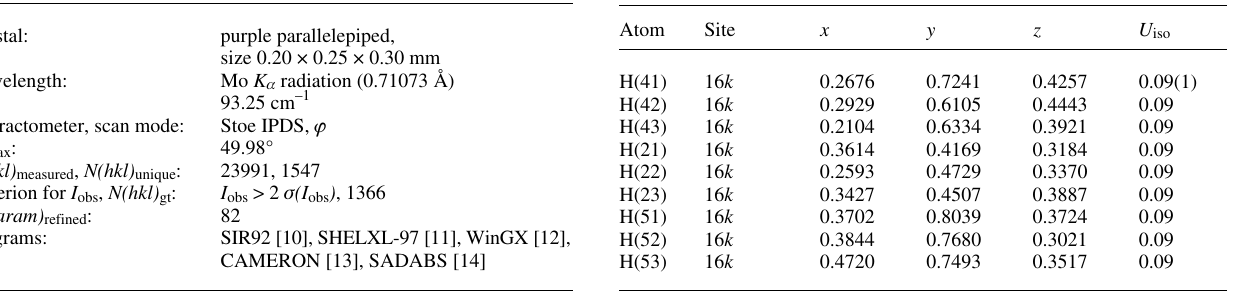
Table 2. Atomic coordinates and displacement parameters (in Å 2 ) . Table 1. Data collection and